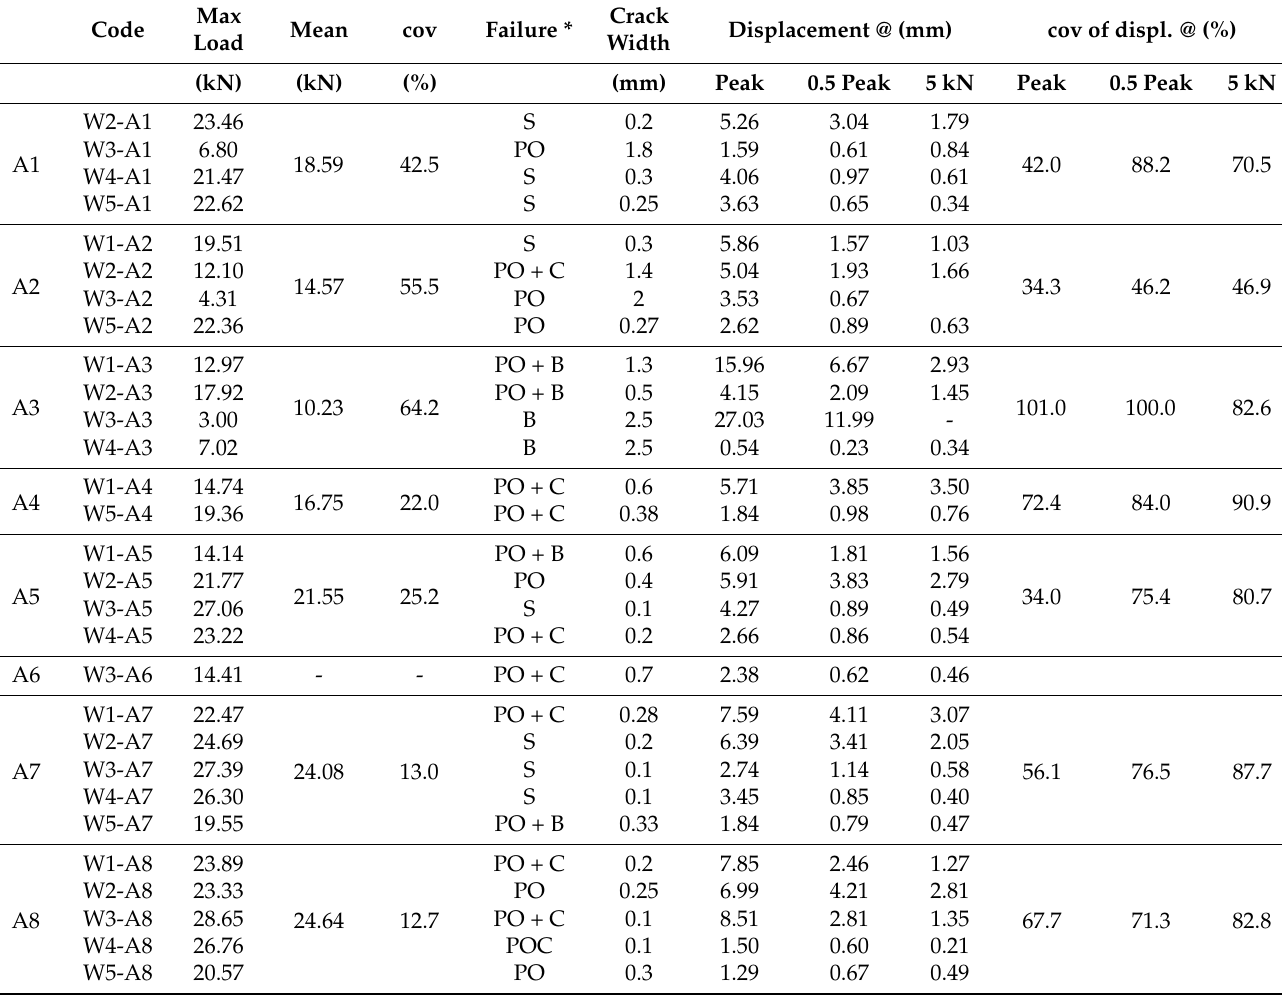
Table 2. Test results evaluated on the basis of anchor